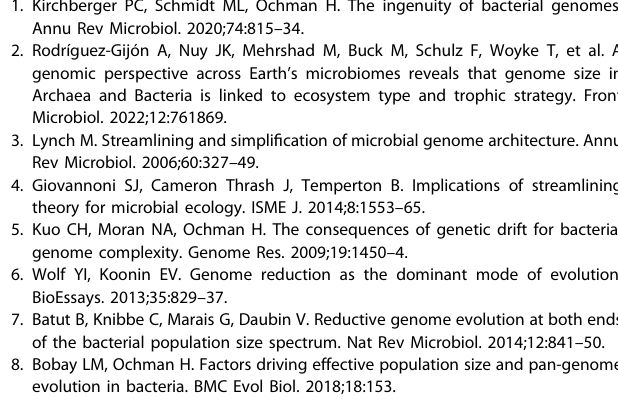
Table S1. Pelagic MAGs can be found on project PRJEB34883 and benthic MAGs on project PRJNA891615. Assembly and binning of the dataset provided in this paper used scripts available at https://github.com/moritzbuck/0053_metasssnake2. Supple- mental material can also be accessed